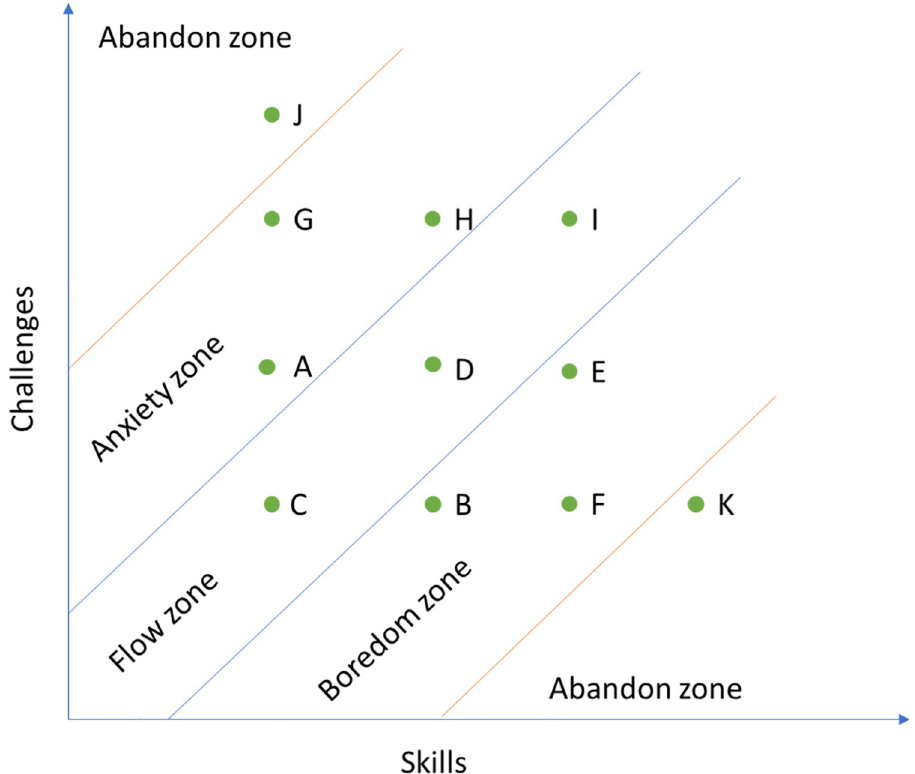
Fig 2. Flow and discomfort